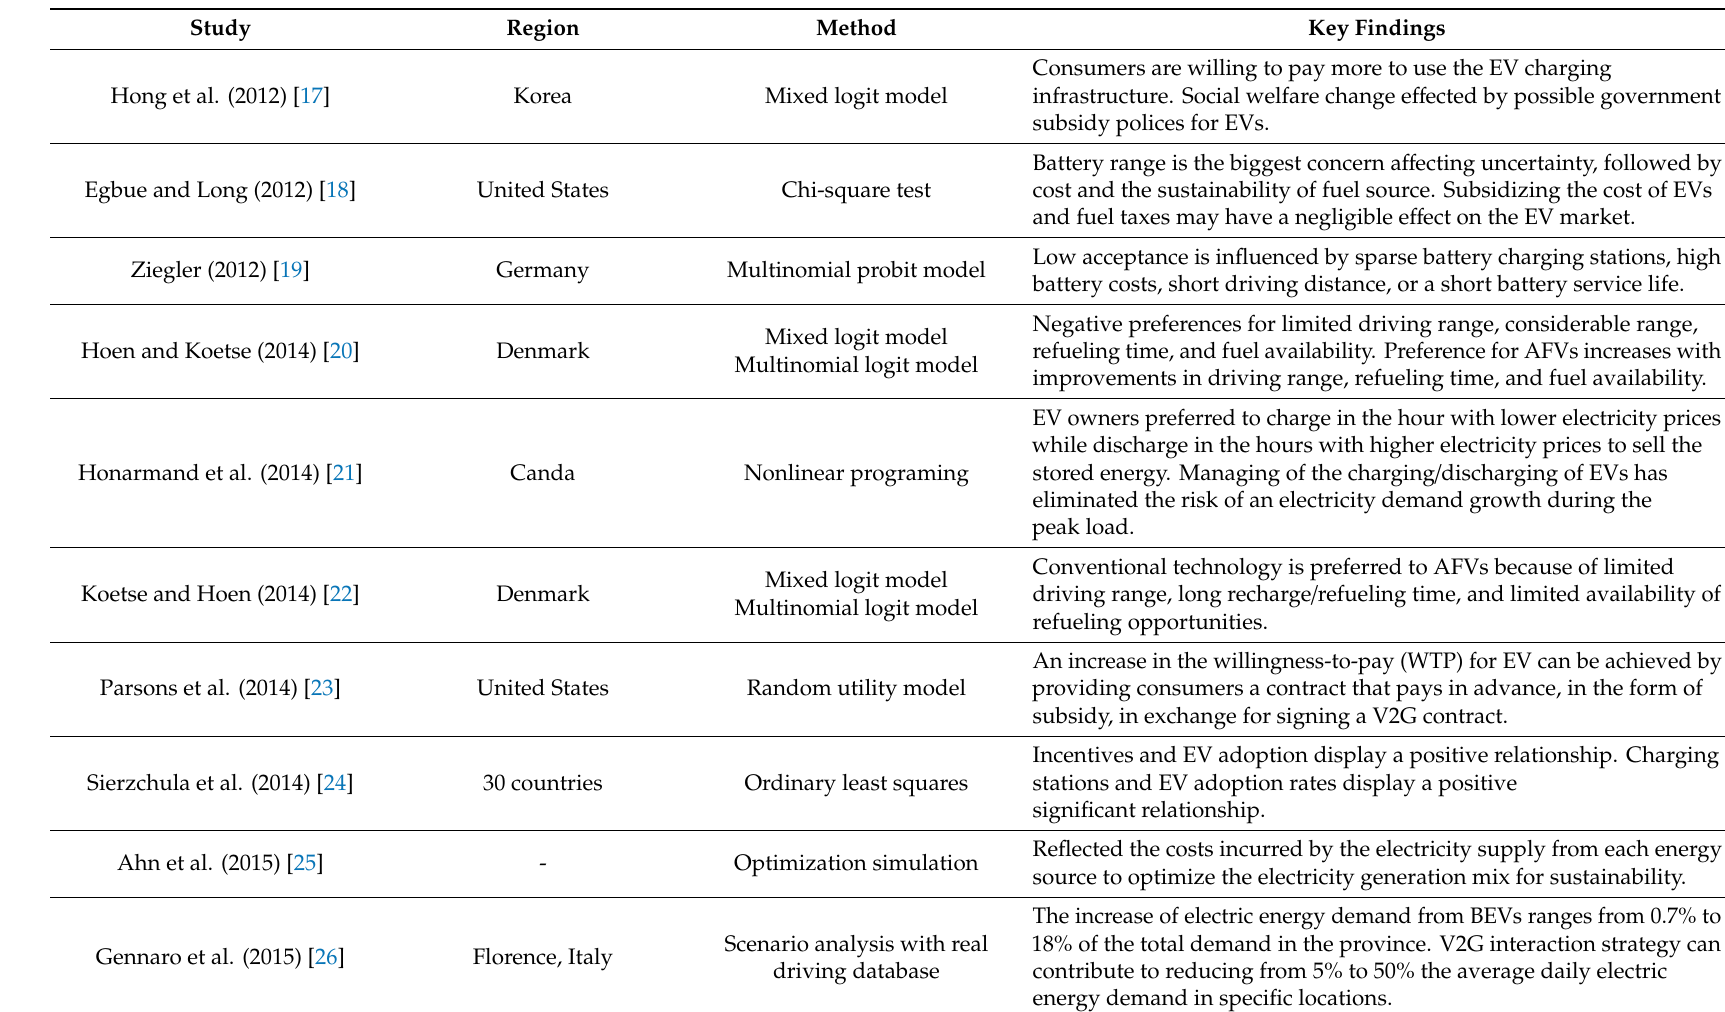
Table 1. A summary of previous